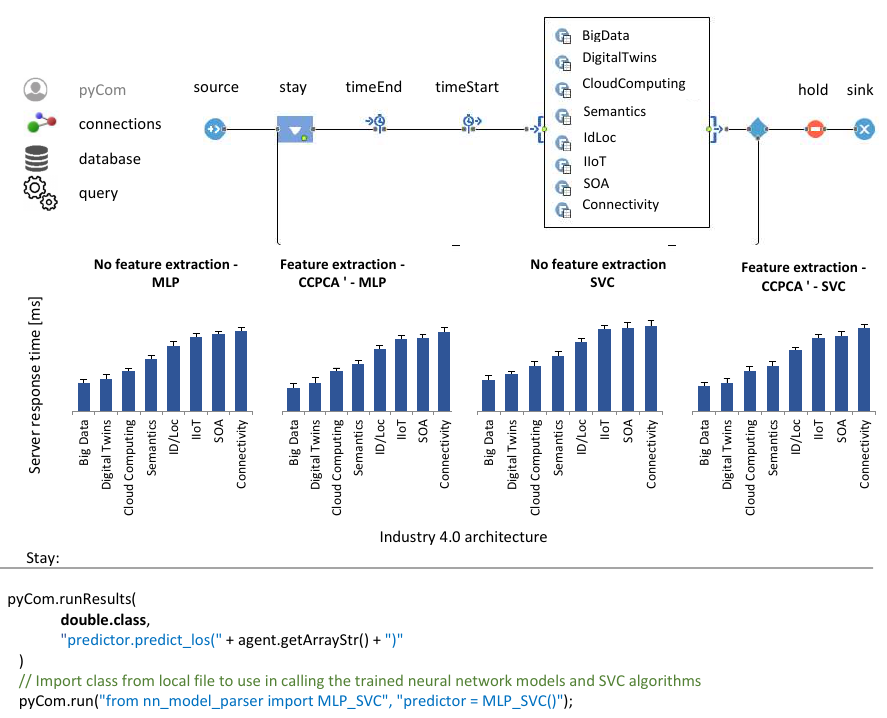
Figure 7. The experimental model developed at AnyLogic.